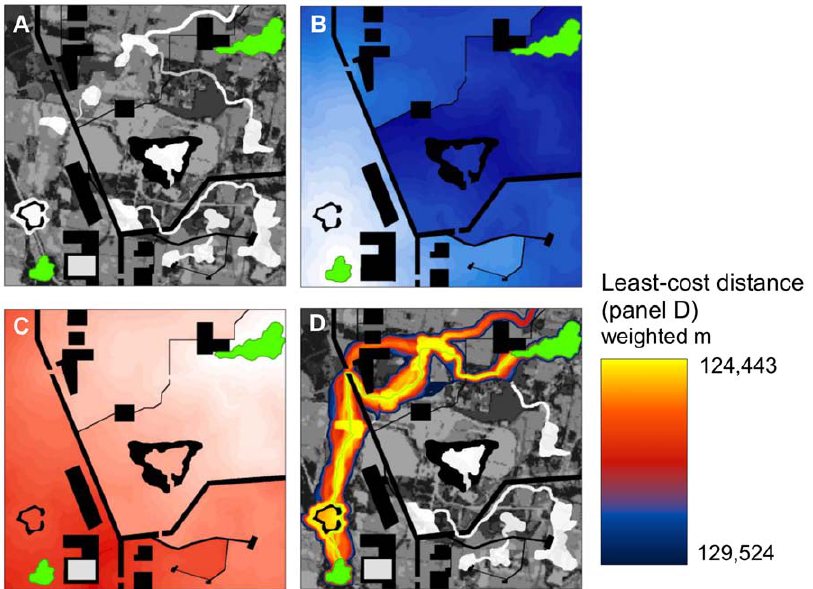
Figure 1. Cost-weighted distance modeling. (A) Example 3 km 6 3 km landscape with a pixel size of 3 m (from [15]). Two habitat patches (green) are embedded in a matrix of land cover types with differing resistance to movement. Resistances range from 1 (white) to 100 (dark grey); complete barriers with infinite resistance (e.g., linear features representing roads and highways) are shown in black. (B) Cost-weighted distance ( CWD ) from leftmost patch, with darker shades representing higher cumulative resistance from the patch. (C) CWD from rightmost patch, with darker shades representing higher cumulative resistance from the patch. (D) Modeled least-cost corridor produced by adding CWD surfaces shown in panels B and C (best 20% of study area shown). The least-costly path (traced in green) has a cumulative least-cost distance ( LCD ) of 124,443 weighted meters.